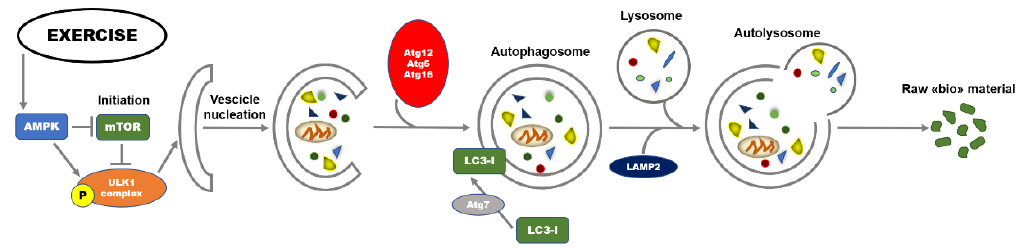
Figure 1. Overview of basic molecular mechanisms involved in initiation of exercise-induced autophagy. Autophagy is a lysosomal-mediated degradation process for primarily degrading damaged cells and dysfunctional organelles to recycle damaged or dysfunctional cellular contents, thereby providing the energy for nascent cells. Exercise, as a newly defined stimulus, can induce autophagy in cells. mTOR and AMPK are currently recognized as the sensors for detecting nutrition and energy efficiency in skeletal muscle, especially in exercise responses. mTOR and AMPK in the initial steps of the autophagy process through phosphorylation interaction with the ULK1 complex, respectively, whereas AMPK inhibits mTOR activity. AMPK: AMP activated protein kinase; Atg: autophagy related gene; LC3: microtubule-associated protein 1A / 1B-light chain 3; mTOR: mammalian target of rapamycin; P: Phosphate; ULK1: Unc-51 like autophagy activating kinase 1.